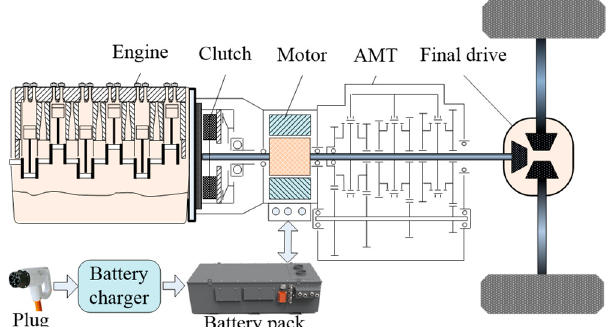
Figure 4. The configuration of the studied plug-in hybrid electric bus (PHEB). Table 1. Main parameters of the PHEB.